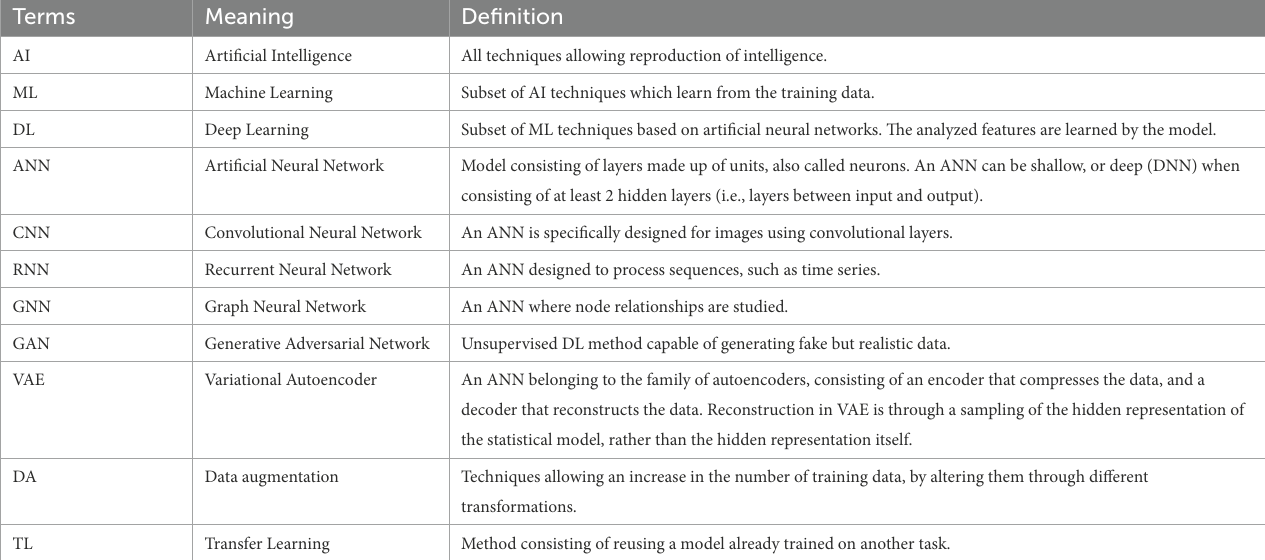
TABLE 1 Glossary of technical